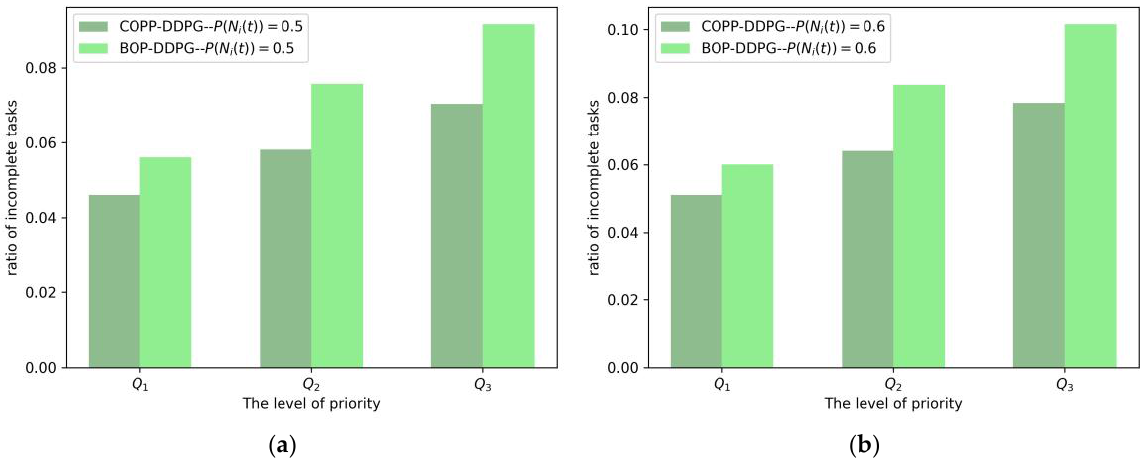
Figure 9. Comparison of ratios of incomplete tasks for two learning algorithms with different priorities: ( a ) performance comparison; ( b ) performance improvement.